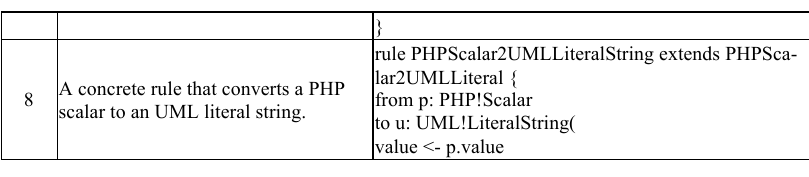
Paper —ADM-Based Hybrid Model Transformation for Obtaining UML Models